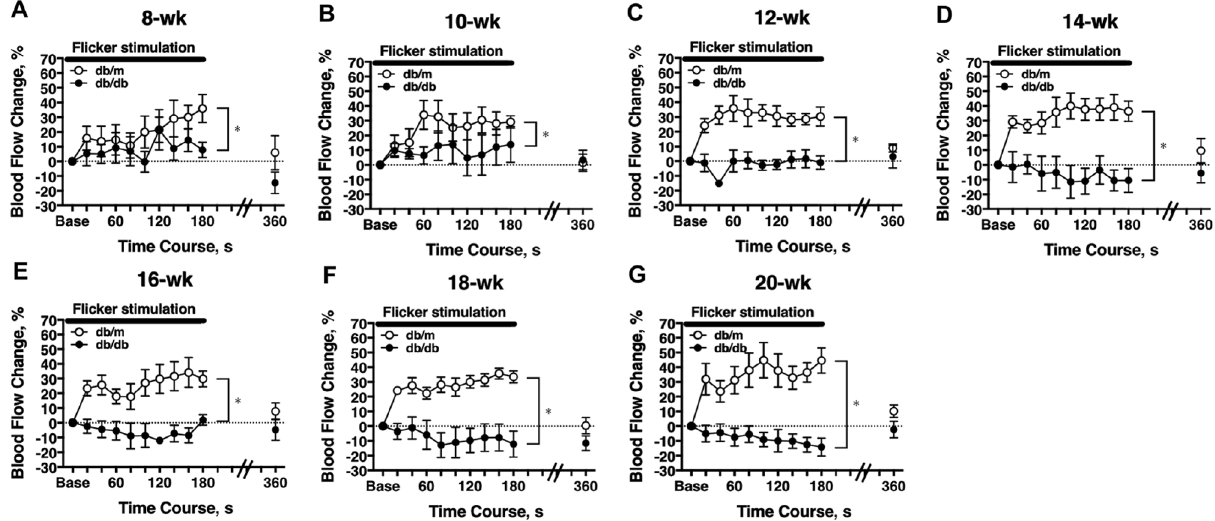
Figure 4. Retinal blood flow response to flicker stimulation. Retinal blood flow was longitudinally assessed in db/db (n = 6) and db/m (n = 6) mice from 8 to 20 weeks of age. During the period of flicker light stimulation, retinal blood flow increased significantly in db/m mice from 8 weeks ( A ) to 20 weeks ( G ) of age and in db/db mice at 8-week ( A ) and 10-week ( B ) old. When the db/db mice grew older ( C – G ), retinal blood flow changes in response to flicker light were not significant (one-way repeated measures ANOVA). The flicker-induced flow response was significantly blunted in db/db mice for each age studied (two-way repeated measures ANOVA). The retinal blood flow in db/m mice returned to baseline at three minutes after termination of light stimulation, and there was no difference between groups (two-way repeated -measures ANOVA). *P < 0.05 between groups; Solid bar = period of flicker